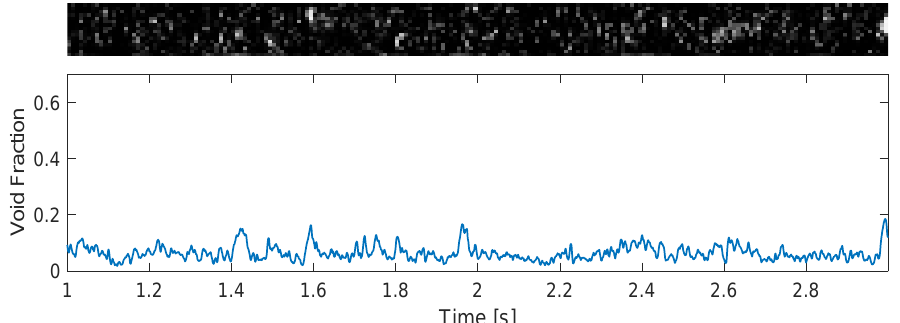
Figure 12. Gas–liquid distribution ( top ) and volume fraction of air ( bottom ) of a bubbly flow measured by the wire-mesh sensor installed upstream of the ISS for a water flow rate of 150 L/min and an air flow rate of 20 Ln/min. The two images correspond to the same data and share the same time axis. In the top image, white corresponds to gas and black to liquid, with the light intensity of gray pixels proportional to the local gas fraction measured by the WMS, such that bubbles smaller than the sensing area of the wire-mesh sensor are represented in